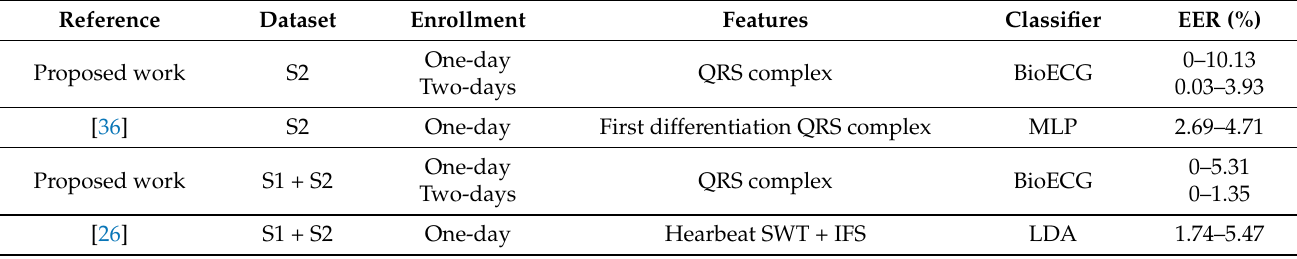
Table 9. Comparison with similar works that use the proposed database. Results are represented in a range of EER, where the first value is the result for verification with data in the same conditions as the enrollment. The range upper bound is the result for verification using data after